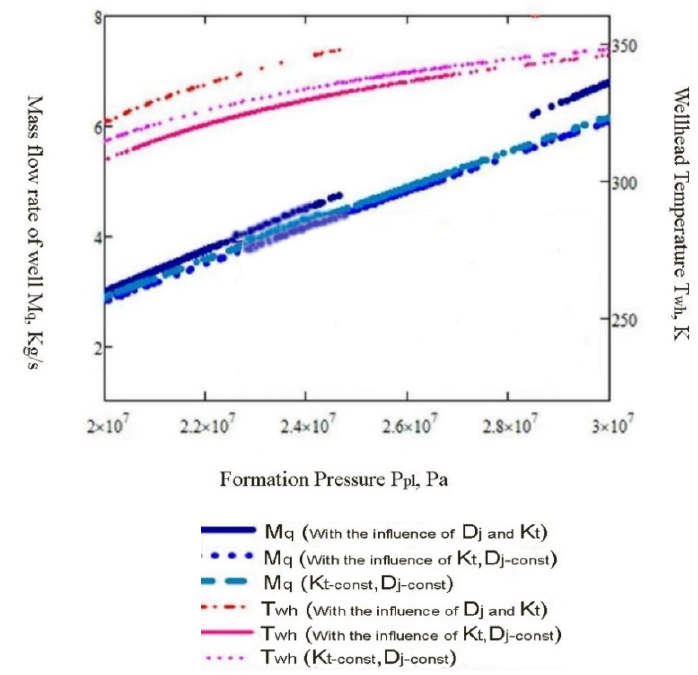
Figure 2. The dependence of M q ( P pl ) and T wh ( P pl ) on the basis of dynamic changes in the thermal conductivity of rocks and the effect of throttling of the extracted fluid.